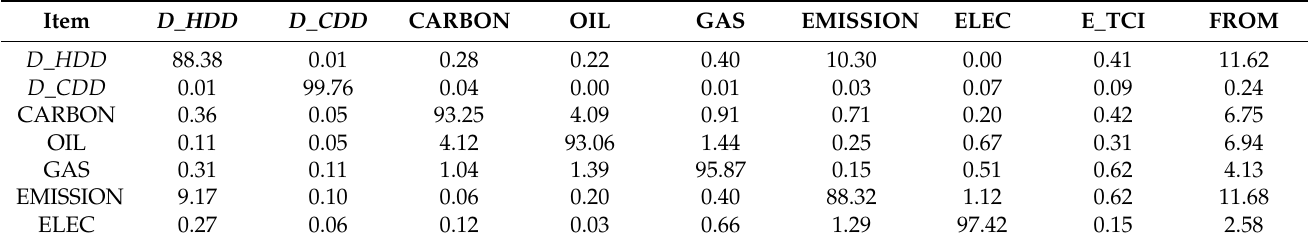
Table 6. The static spillover matrix of different markets under climate change.